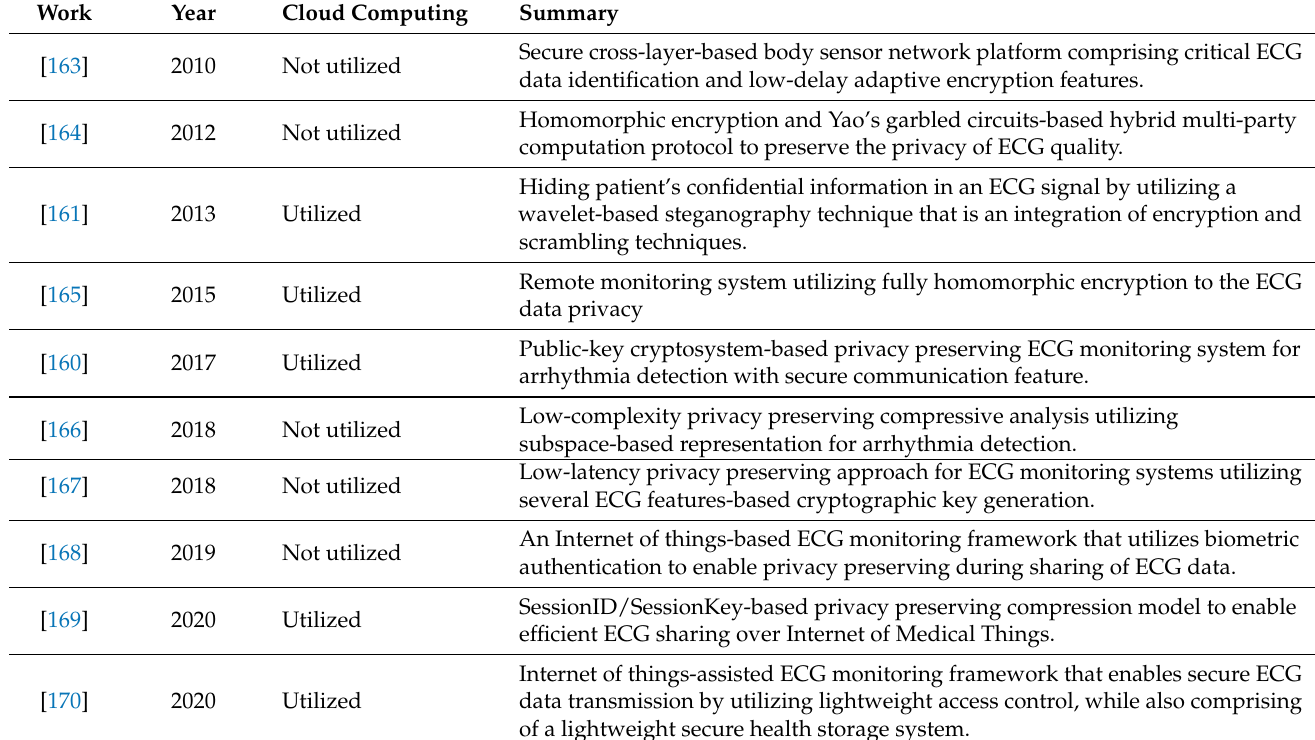
Table 6. Existing privacy preservation techniques used in ECG monitoring